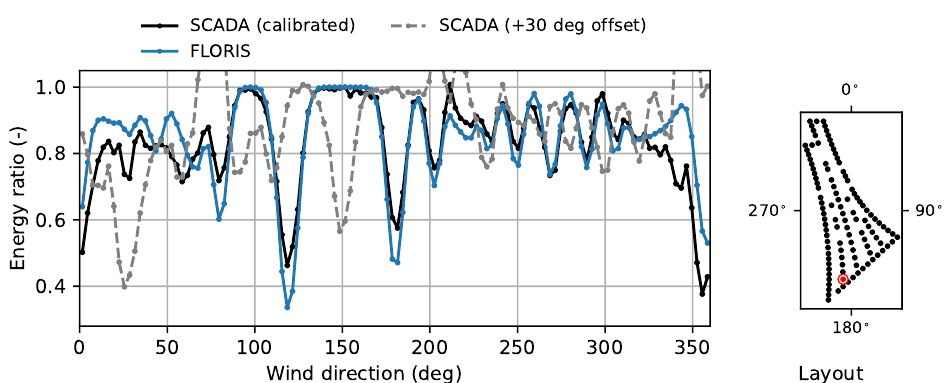
Figure 3. Example of the Northing calibration by optimizing the Pearson correlation coefficient between FLORIS predictions and the SCADA data for various bias correction values. The example shows the energy ratio curves for the Anholt wind farm, test Turbine 32. The reference turbines are the upstream turbines within a 5 km radius, and the reference wind direction measurement (which is calibrated) is the average of the wind direction measurements reported by Turbines 30 and 31. The layout schematic on the right shows the location of Turbine 32 in the wind farm.